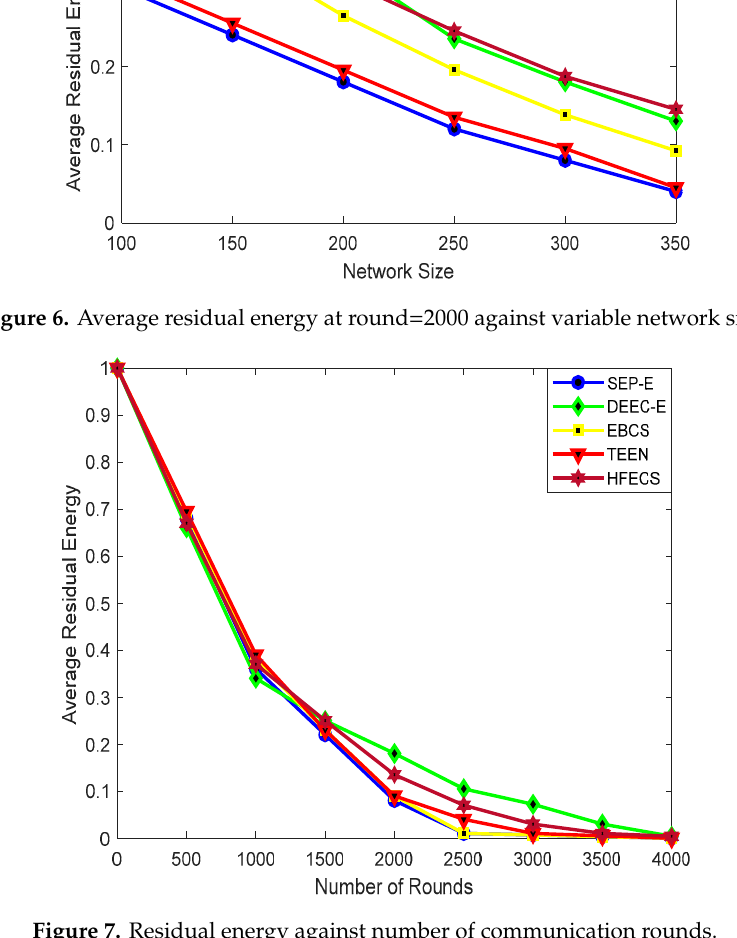
Figure 7. Residual energy against number of communication rounds. Table 11. Percentage improvement of HFECS in terms of average residual energy.